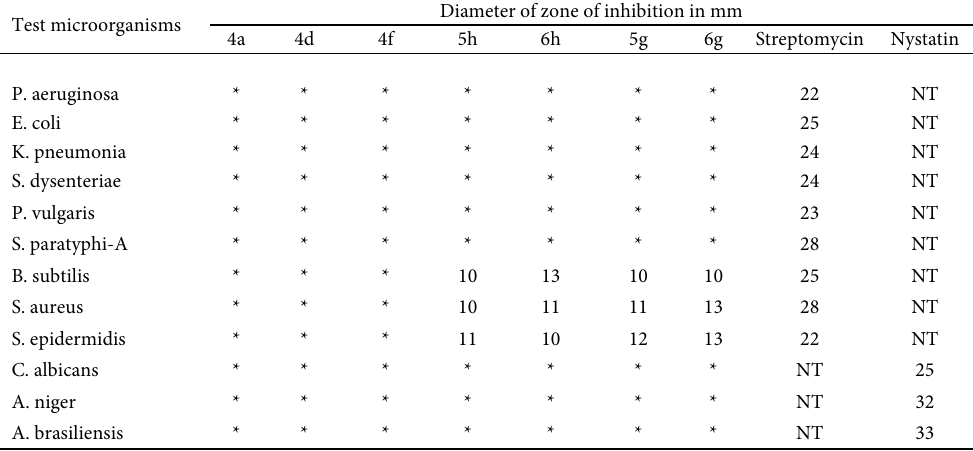
Table 2. In vitro antimicrobial activity of the prepared compounds by agar diffusion assay. Test microorganisms